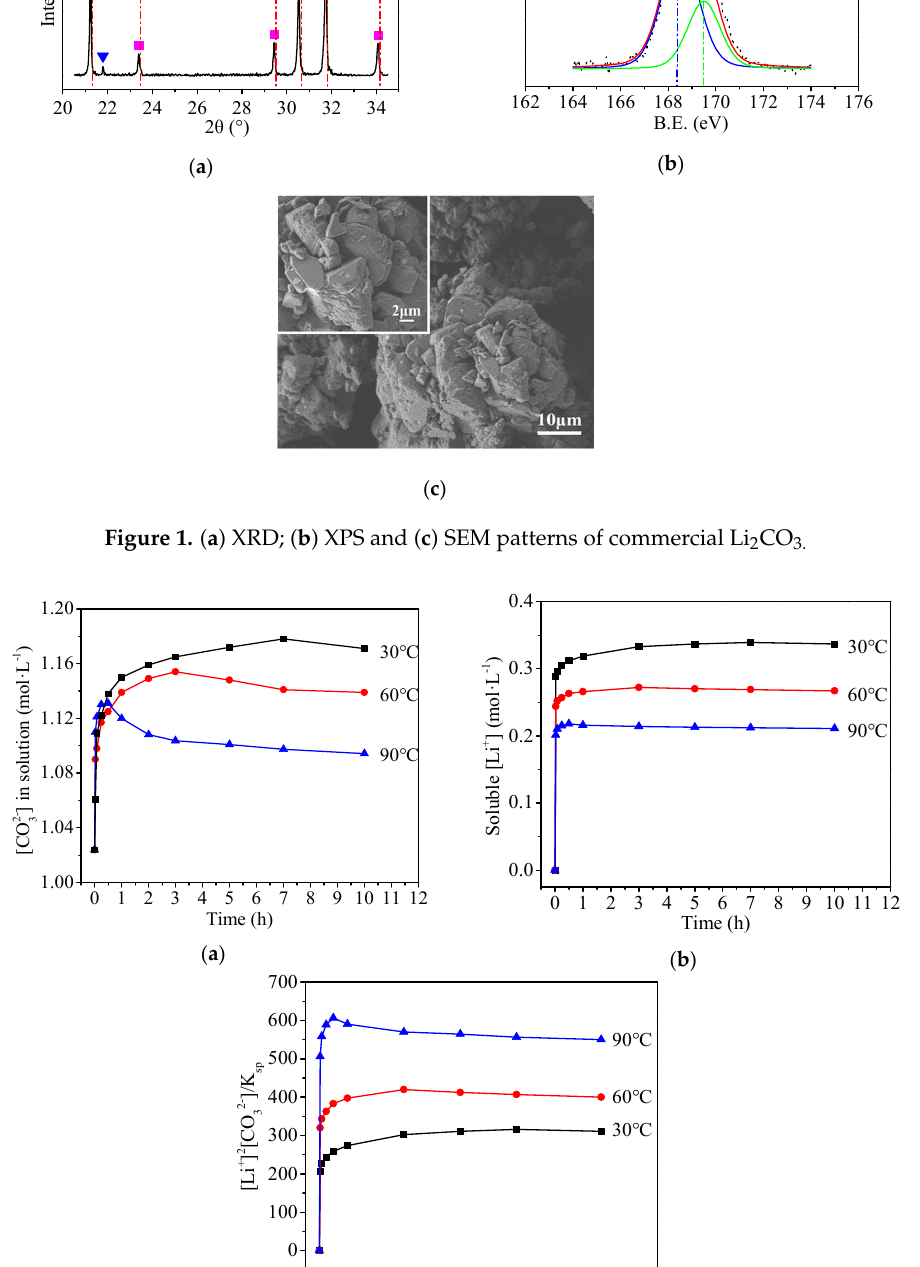
2 − ] and ( c ) supersaturation with reaction 3